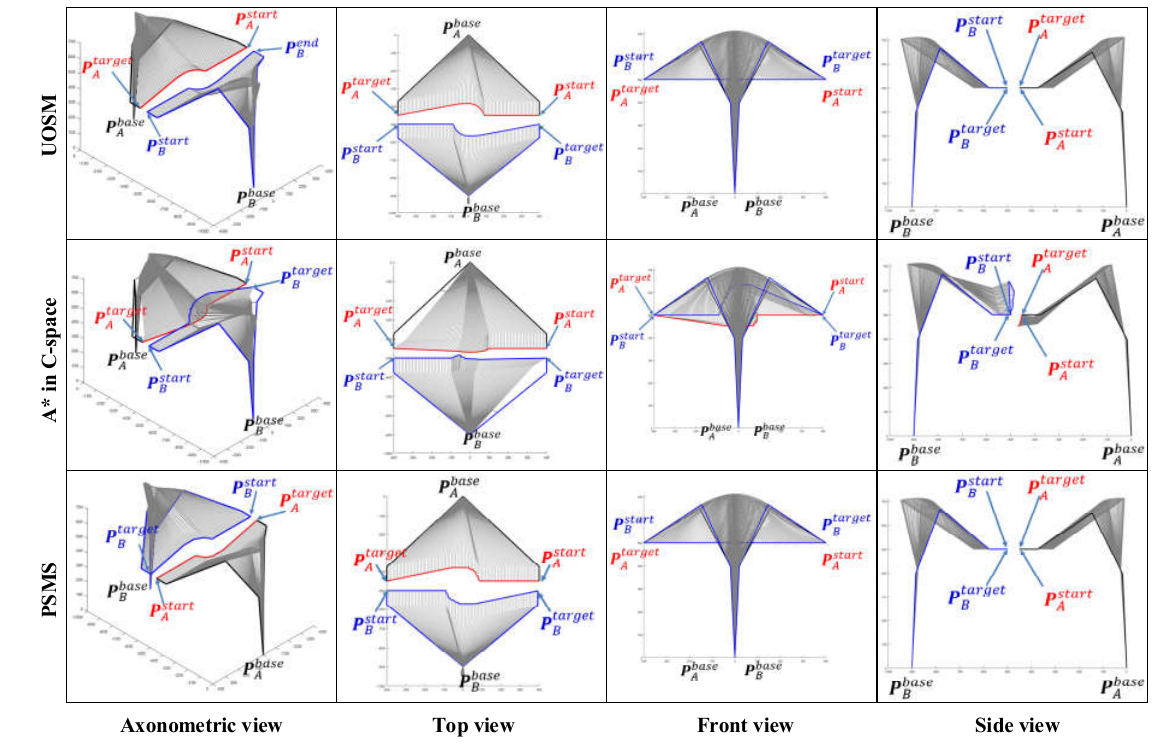
Figure 14. Comparison of simulation results of three path-planning algorithms for Case 1.